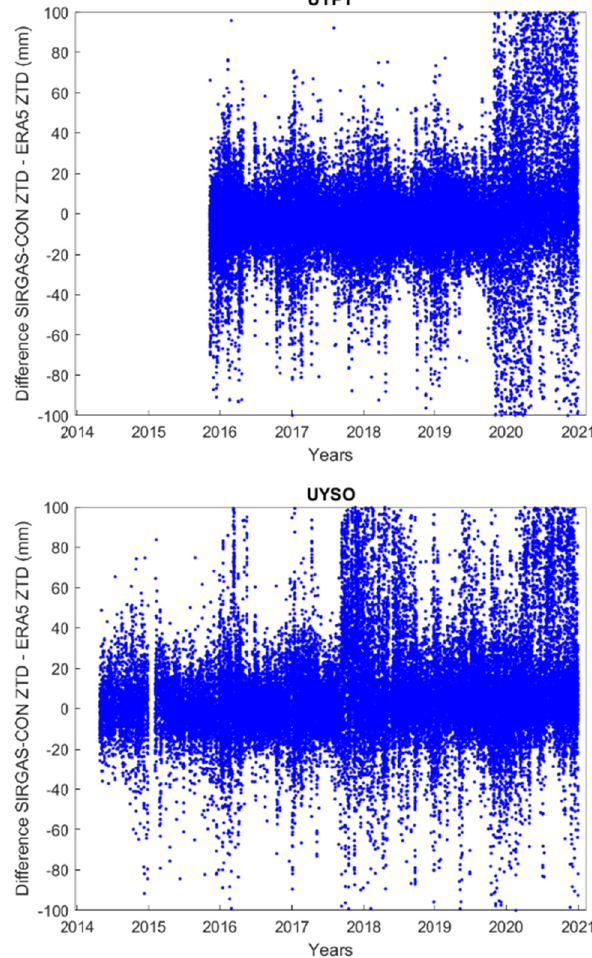
Figure 7: SIRGAS - CON ZTD and ERA5 ZTD di ff erences for stations ( a ) UYPT and ( b )